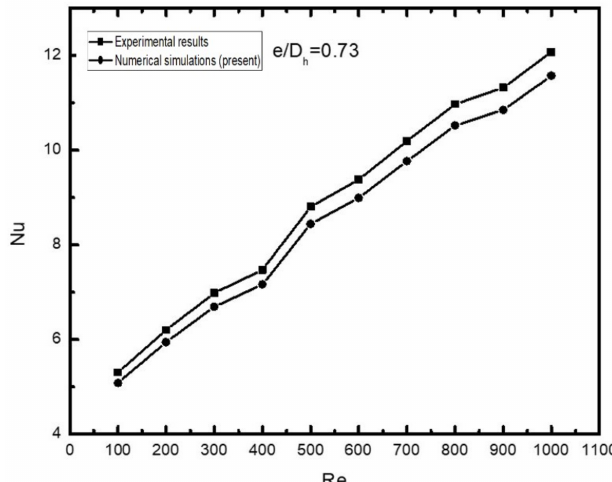
Figure 8. Nusselt number ( Nu ) vs. Re for ribbed MCHS experimental [5] and numerical.